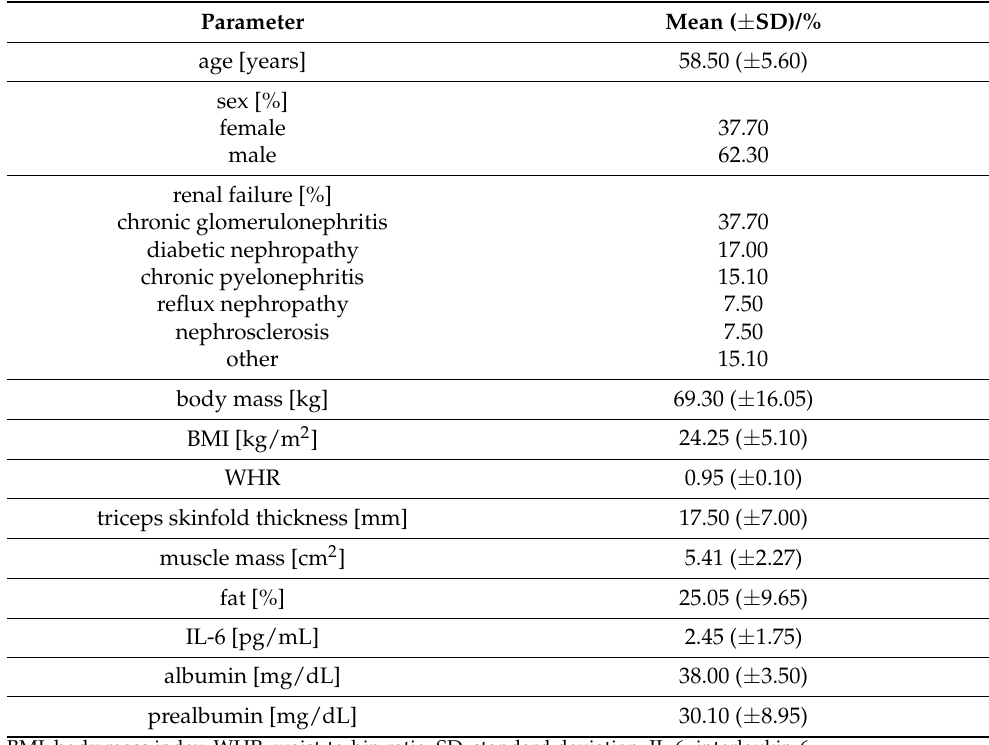
Table 2. Characteristics of the study group ( n =